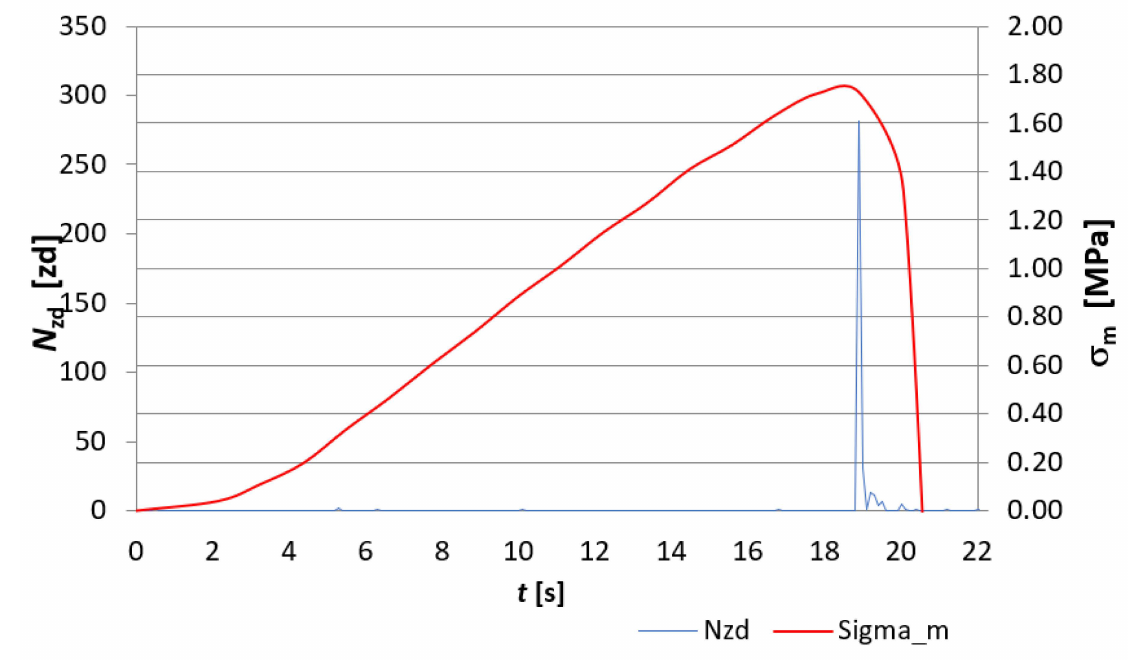
Figure 8. Recording of the event rate N zd and bending stress σ m versus time for the D3 board.